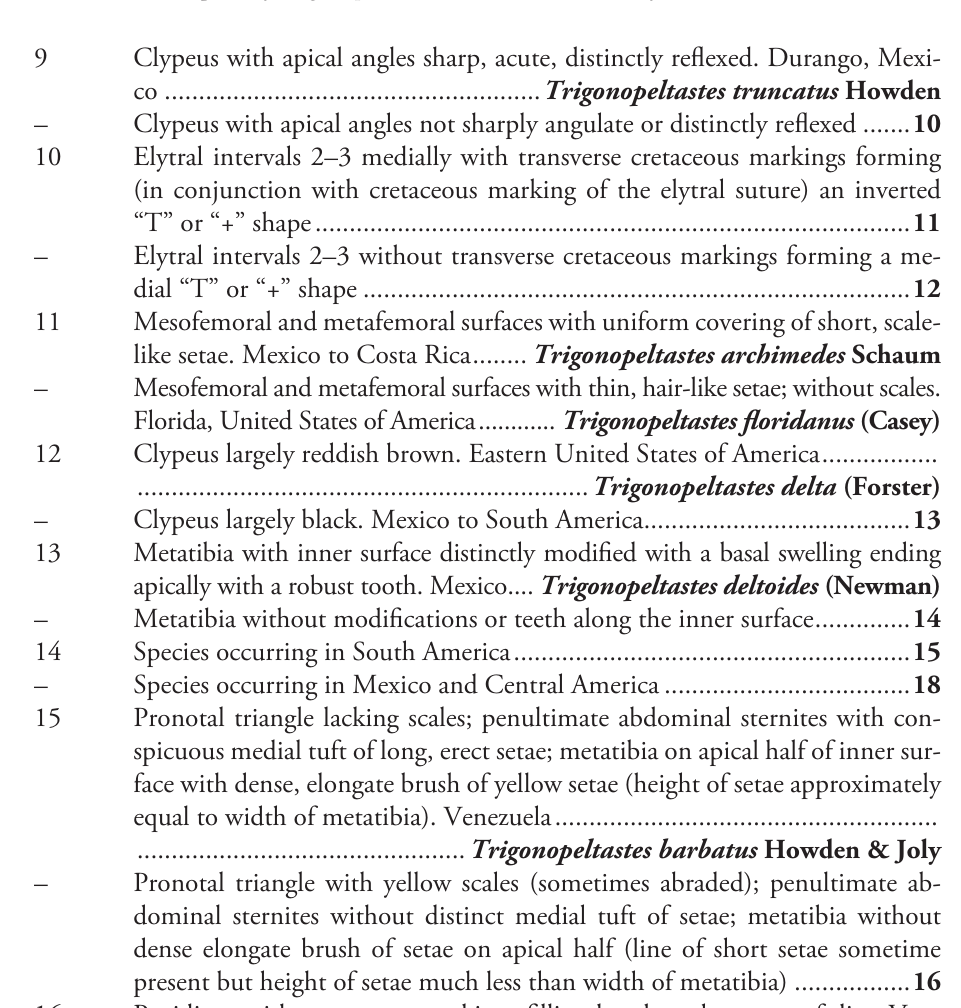
Pronotal triangle with yellow scales (sometimes abraded); penultimate ab- dominal sternites without distinct medial tuft of setae; metatibia without dense elongate brush of setae on apical half (line of short setae sometime Pygidium with cretaceous markings filling basolateral corners of disc. Ven-